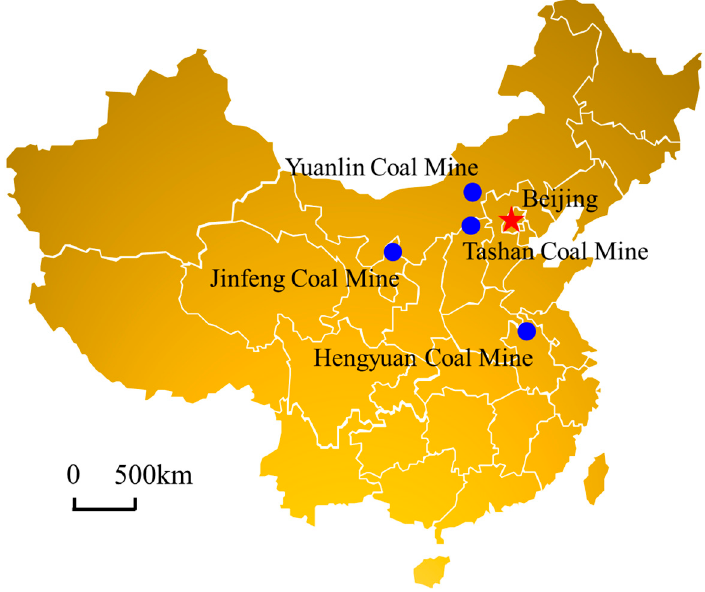
Figure 8. Locations of four typical mines.